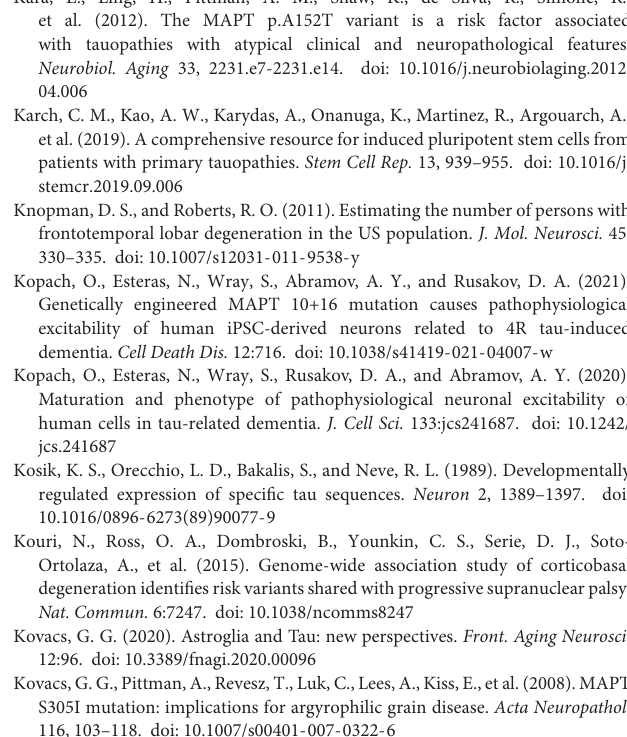
S305I mutation: implications for argyrophilic grain disease. Acta Neuropathol. 116, 103–118. doi: 10.1007/s00401-007-0322-6